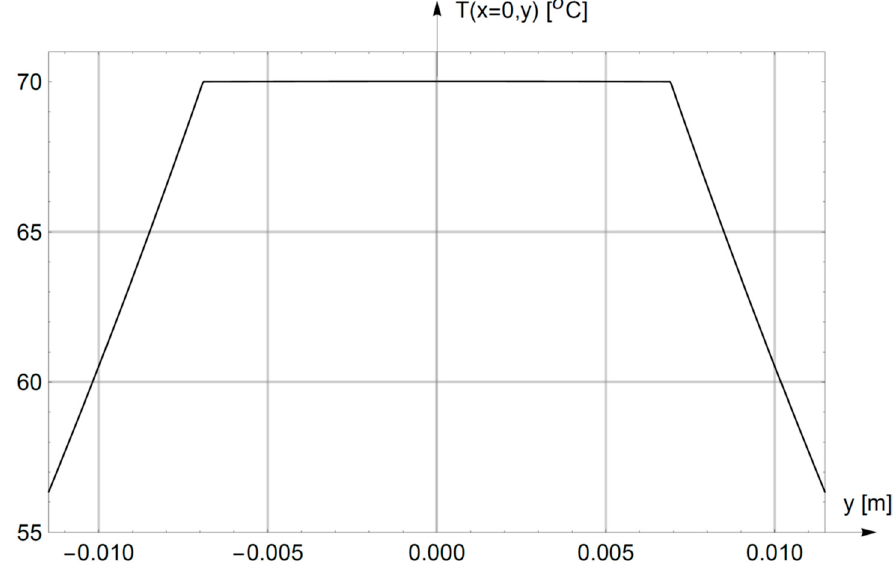
Figure 3. Temperature distribution on the minor axis ( x = 0) of the elliptical conductor under current load I cr = 574.5 A.